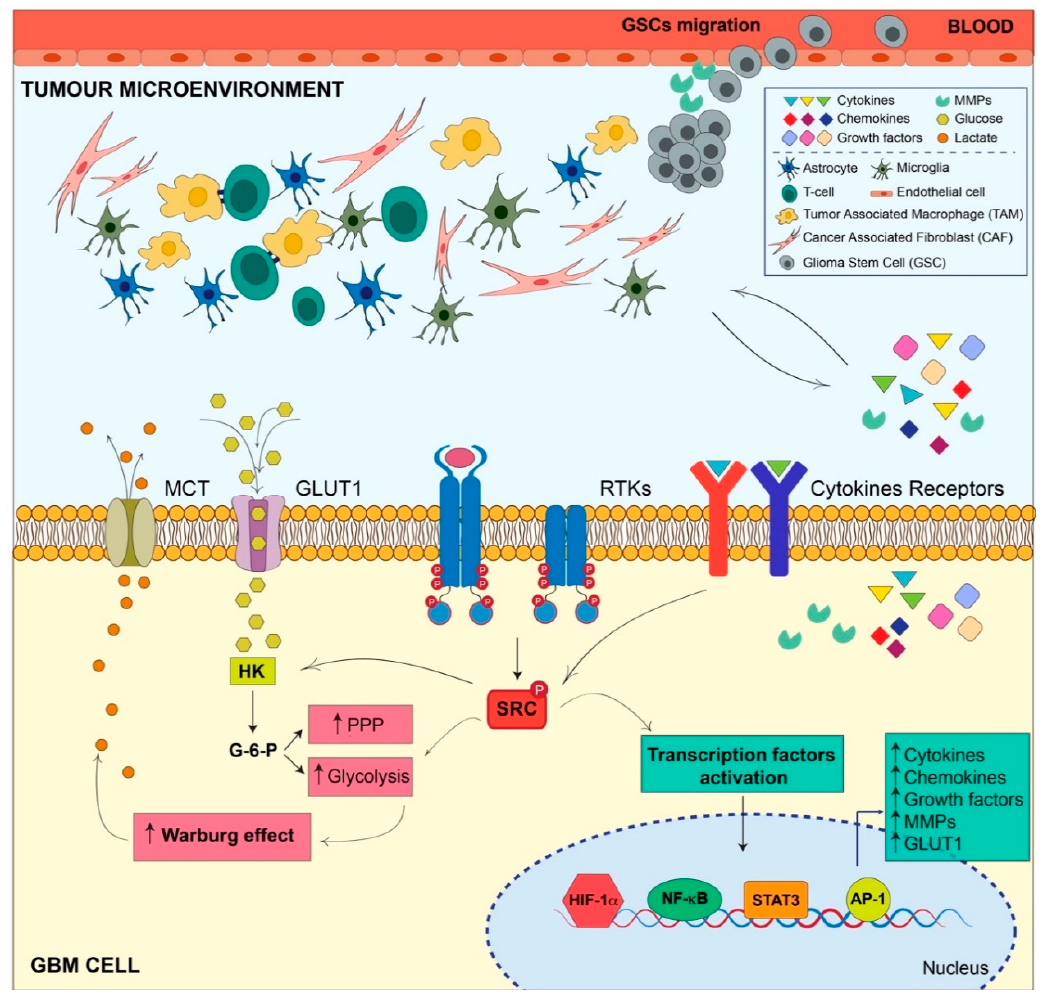
Figure 2. SRC constitutive activation modulates inflammation and metabolism concurring to tumor microenvironment sustainment in GBM. SRC constitutive activation in GBM is mainly caused by receptor tyrosine kinases (RTKs) aberrant signaling. SRC hyperactivation affects metabolism by inducing the activity of hexokinase (HK), responsible for the formation of glucose-6-phosphate (G-6-P) intermediate, feeding both the pentose phosphate pathway (PPP) and glycolysis. Importantly, SRC aberrant activity directly induces aerobic glycolysis (Warburg effect) causing lactate accumulation and its secretion in the extracellular matrix. SRC aberrant activity is also responsible for the stabilization and activation of transcription factors (i.e., NF- κ B, STAT3, HIF1 α , and AP-1) inducing the expression of proinflammatory cytokines, chemokines, growth factors, and matrix metalloproteases (MMPs). Massive production of pro-inflammatory molecules and growth factors, glucose deprivation, and lactate accumulation in the extracellular matrix concur with the formation of an important tumor microenvironment in which tumor and nontumor cells cooperate to sustain each other in a positive feedback loop concurring to GBM tumor aggressiveness and invasiveness.